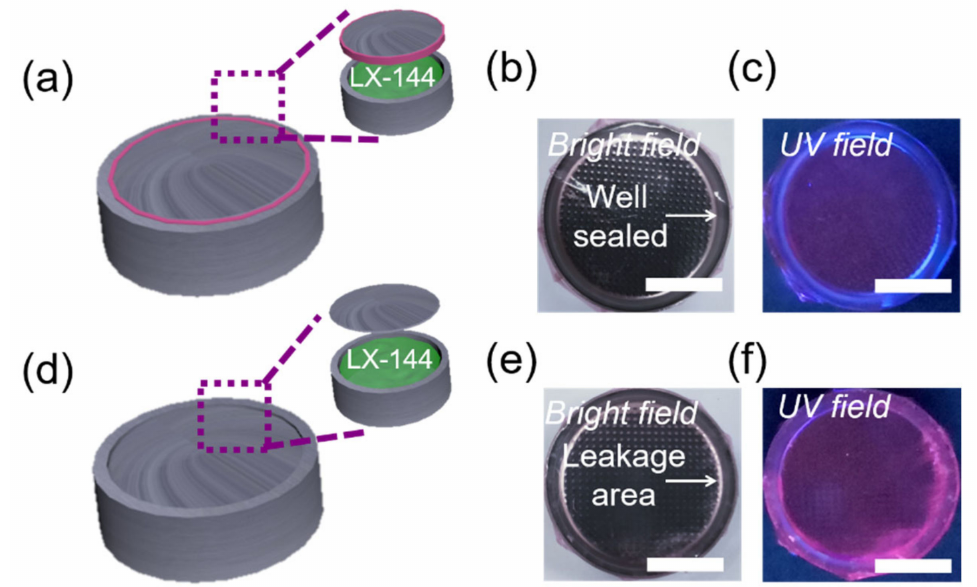
Figure 4. ( a ) Schematic illustration of well-sealed Mg battery model; images of the Mg battery model coated with L-AIE-F ( b ) in bright field and ( c ) upon UV irradiation (365 nm), scale bar = 0.5 cm; ( d ) schematic illustration of a leaking Mg battery model; images of a leaking Mg battery model coated with L-AIE-F ( e ) in bright field and ( f ) upon UV irradiation (365 nm), scale bar = 0.5